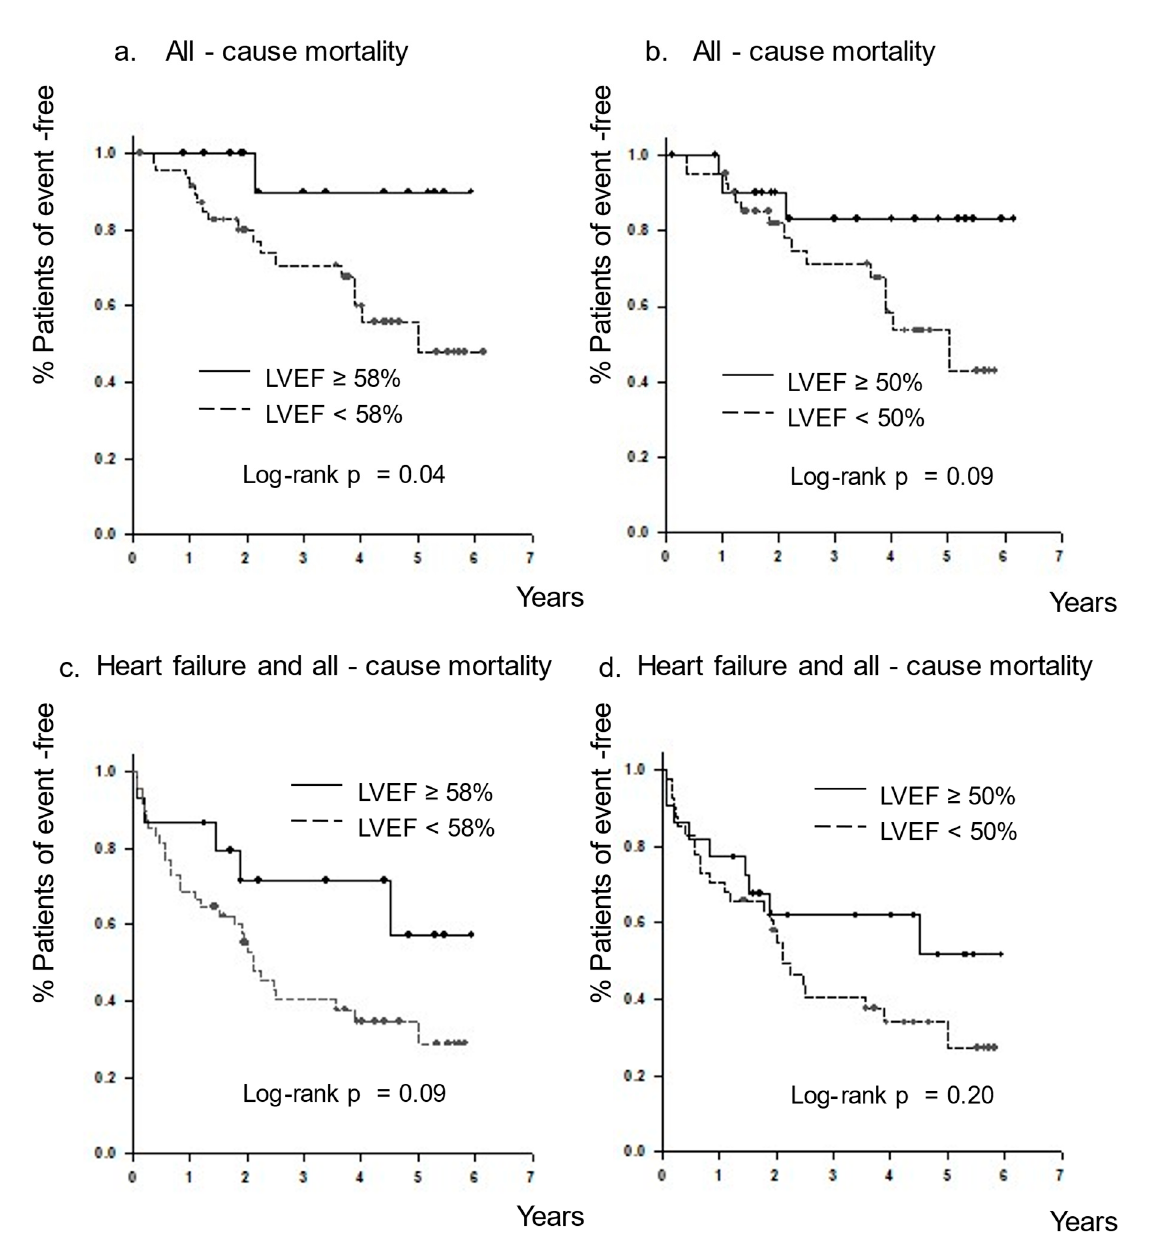
Figure 5. For endpoint-free survival analysis, Kaplan–Meier curves were generated and compared using the log-rank test. Kaplan–Meier curves for all-cause mortality in patients with a left ventricular ejection fraction (LVEF) of ≥ 58% ( a ) and ≥ 50% ( b ). The survival rate was significantly higher in patients with an LVEF of ≥ 58% than in those with an LVEF of < 58%. No significant differences were found between patients with an LVEF of ≥ 50% and those with <50%. Kaplan–Meier curves for the combined endpoint of subsequent heart failure and all-cause mortality in patients with an LVEF of ≥ 58% ( c ) and ≥ 50% ( d ). No significant differences were found between patients with an LVEF of ≥ 58% and <58%, as well as between patients with an LVEF of ≥ 50% and <50% .